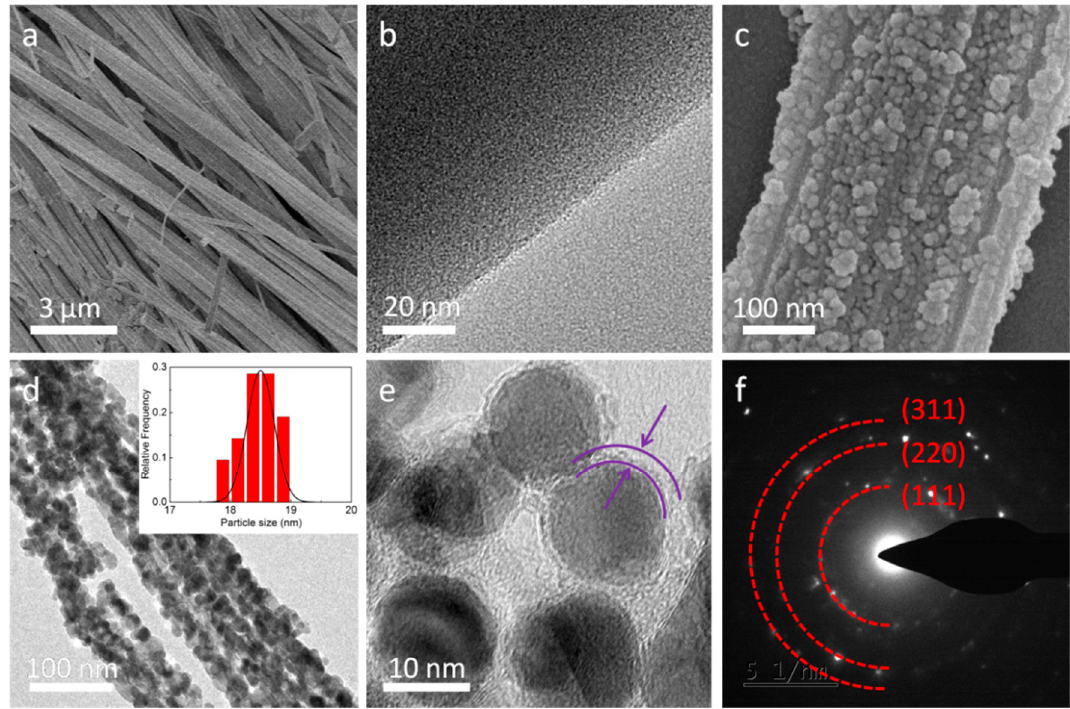
Figure 3. SEM ( a ) and TEM ( b ) image of the MnFe-based oxalate, SEM image ( c ), TEM images ( d , e ) and SAED pattern ( f ) of the MnFe 2 O 4 @C composite.